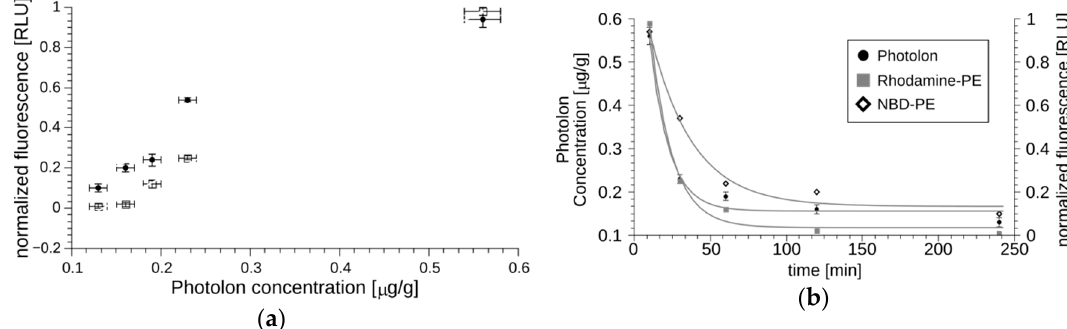
Figure 4. The pharmacokinetic characteristics of liposomal Photolon injected in the jugular vein of Sus scrofa f. domestica . Panel ( a ) shows the correlation between the fluorescence of Photolon and NBD-PE or Rhodamine-PE measured in blood. All points in the plot were determined for a specific time-point, for which both the fluorescence of entrapped Photolon and the labeled lipid capsule were quantitated, and the resulting values are shown on the OX and OY axis, respectively. The experimental data can be fitted with straight lines, which indicates that Photolon remains in liposomes throughout the duration of the experiment. Panel ( b ) shows a pharmacokinetic curve for fluorescently labeled lipids and Photolon. The decreasing fluorescence values (with half-time equal to approximately 20–30 min indicating e ffi cient elimination).